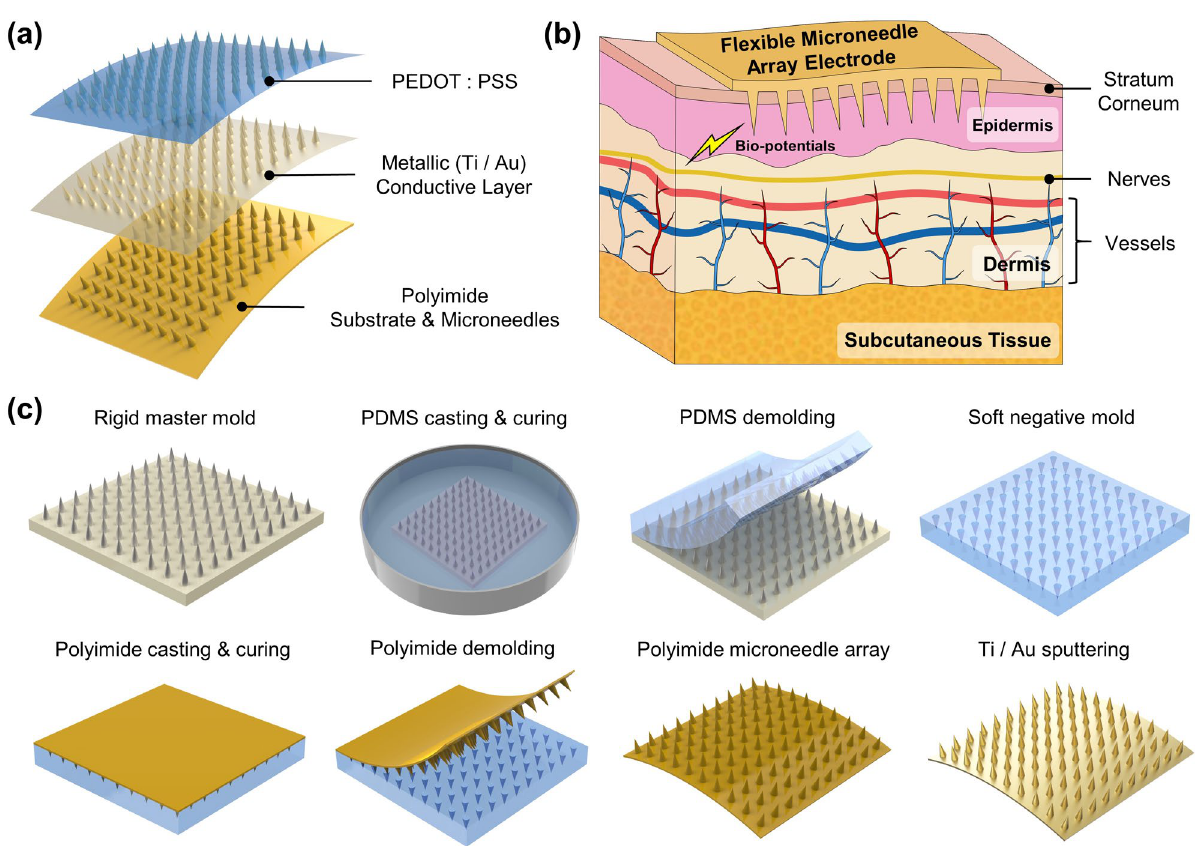
Fig. 1 a Schematic view of the structure and material of the PI-MNA electrode. b Principle of ultraminimally invasive biopotential acquisition by a flexible MNA electrode. c Manufacturing process flow of the PI-MNA